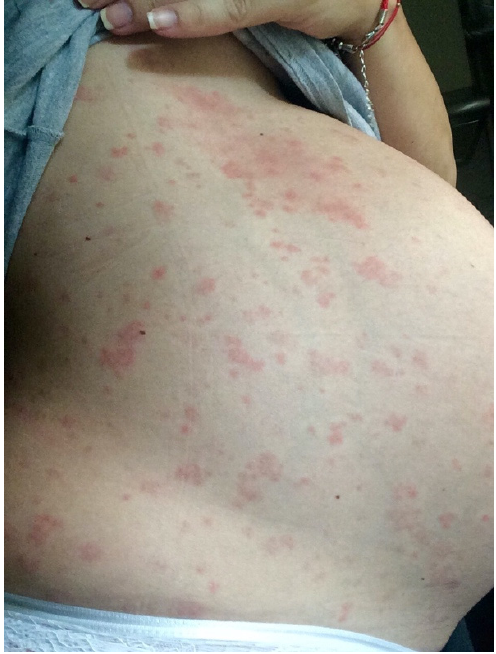
Figure 3. Close representation of the papules and plaques on the abdomen.